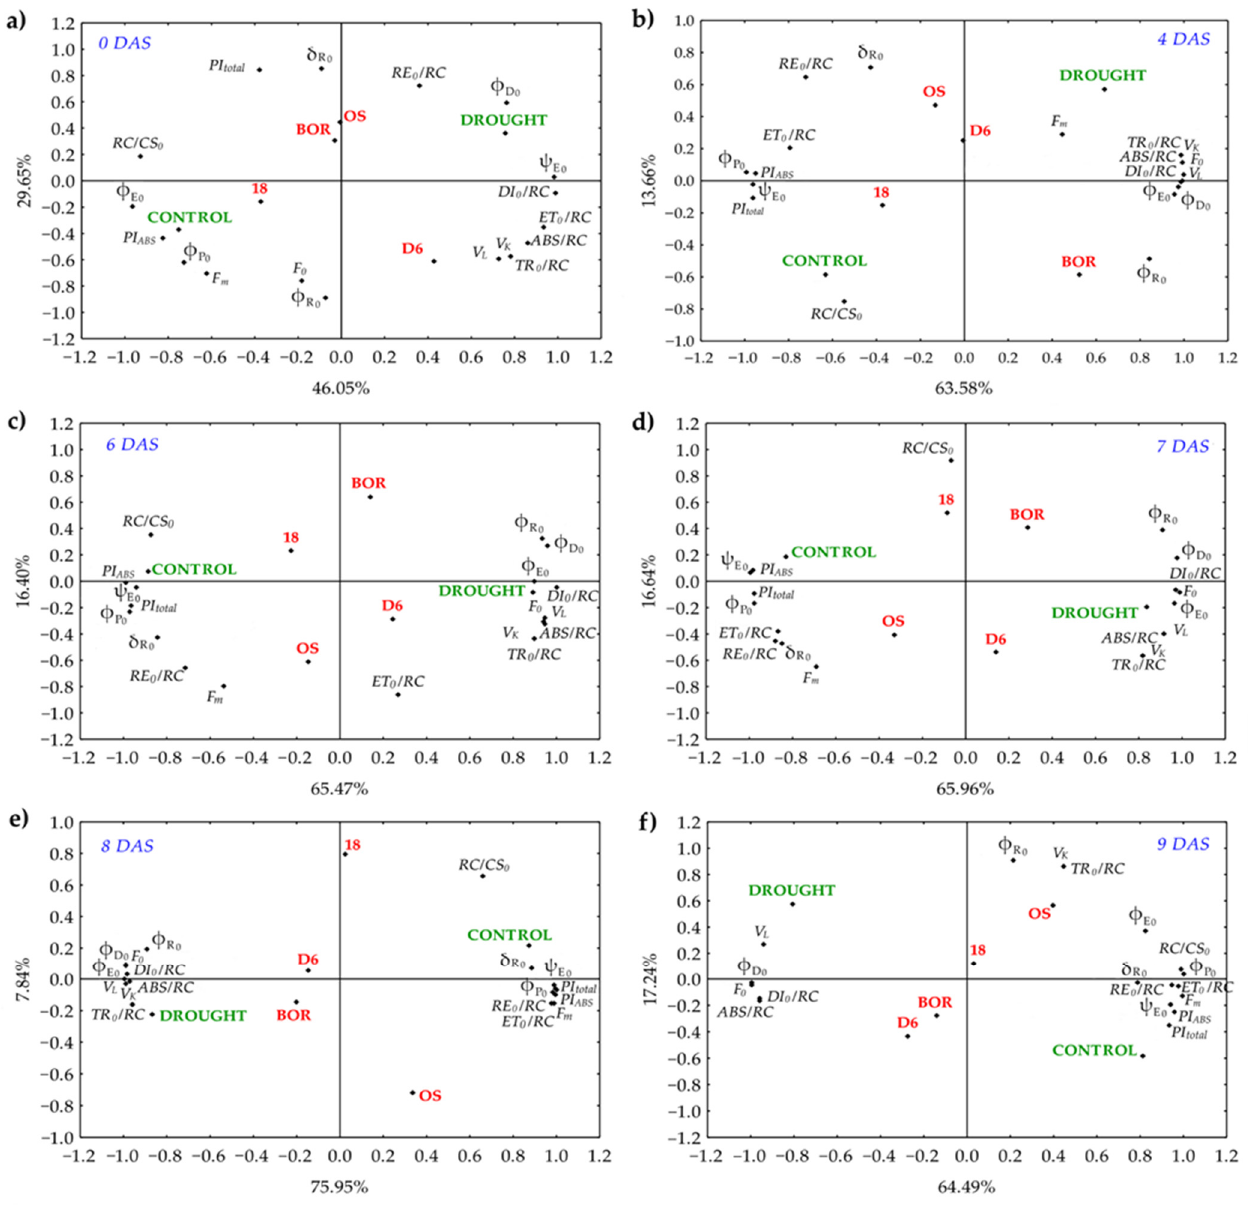
Figure 5. Results of principal component analysis of JIP parameters in the leaves of Obla č inska sour cherry ecotypes (OS, 18, D6, BOR) under control and drought conditions were obtained at 0 ( a ), 4 ( b ), 6 ( c ), 7 ( d ), 8 ( e ), and 9 ( f ) days after stress (DAS).